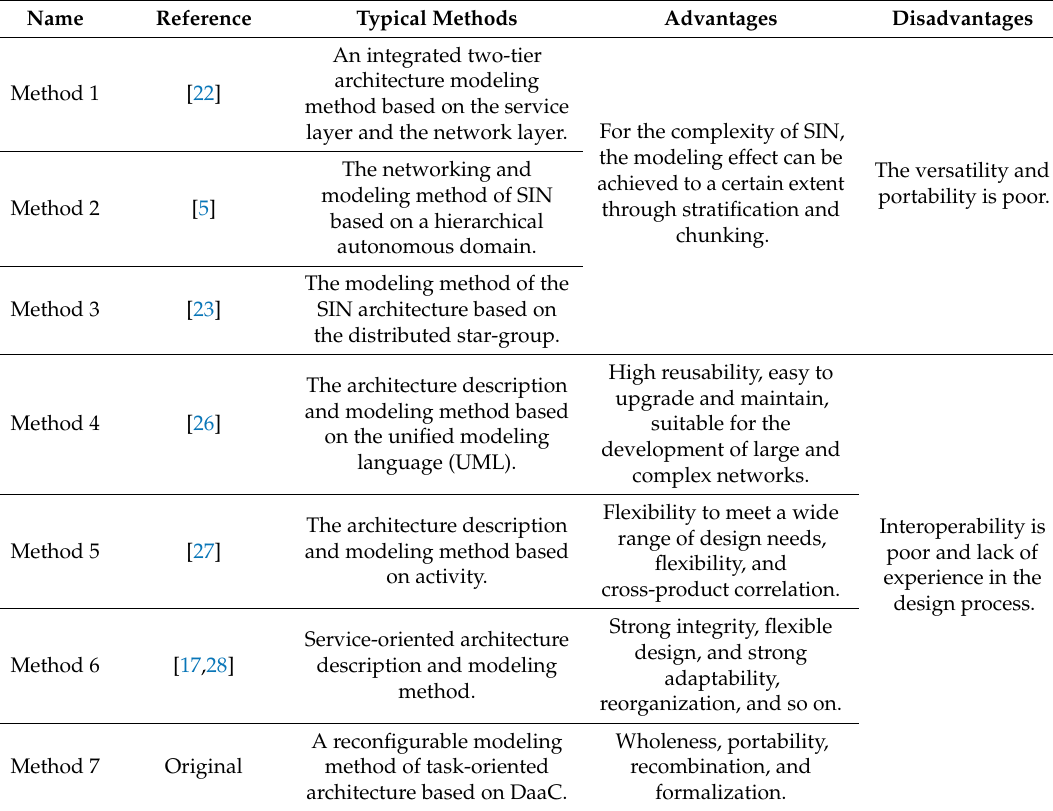
Table 3. Definiteness Analysis of SIN Architecture Modeling